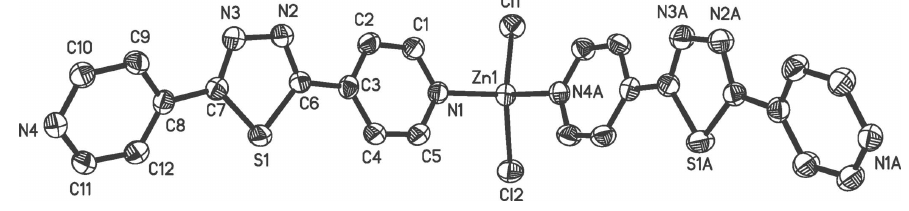
Figure 1 Molecular structure of the title compound showing 30% probability displacement ellipsoids (H atoms are omitted). catena -Poly[[dichloridozinc(II)]- µ -2,5-di-4-pyridyl-1,3,4-thiadiazole- κ 2 N 2 : N 5 ] Crystal